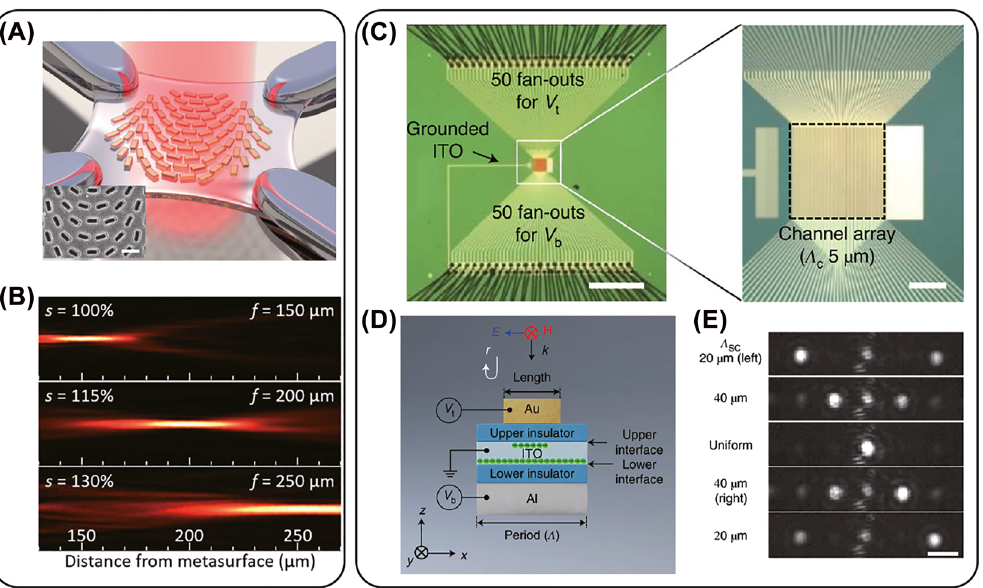
Figure 11: (A) Illustration of a stretched visible meta-lens. The inset shows the fabricated plasmonic gold nanorods. (B) Experimental results of a 1.7 × zoom lens with strain tuned by 30%. (A) and (B) reprinted from [121]. Copyright 2016 American Chemical Society. (C) Microscopic image of an active array with 50 top and 50 bottom terminals. Scale bar, 1 mm. The right image shows a magnified view the active device located in the middle of the fan-outs with a size of 250 × 250 μ m 2 . Scale bar, 100 μ m. (D) Schematic view of the cross section of a single plasmonic nanoresonator, which consists of top gold nanoantenna, insulator spacer and the active ITO layer in the middle. The bottom layer is an Al mirror. (E) Measured intensity profiles for five different steering angles showing linear movements of the focus beam. (C)–(E) reprinted from [315]. Copyright 2020, Springer